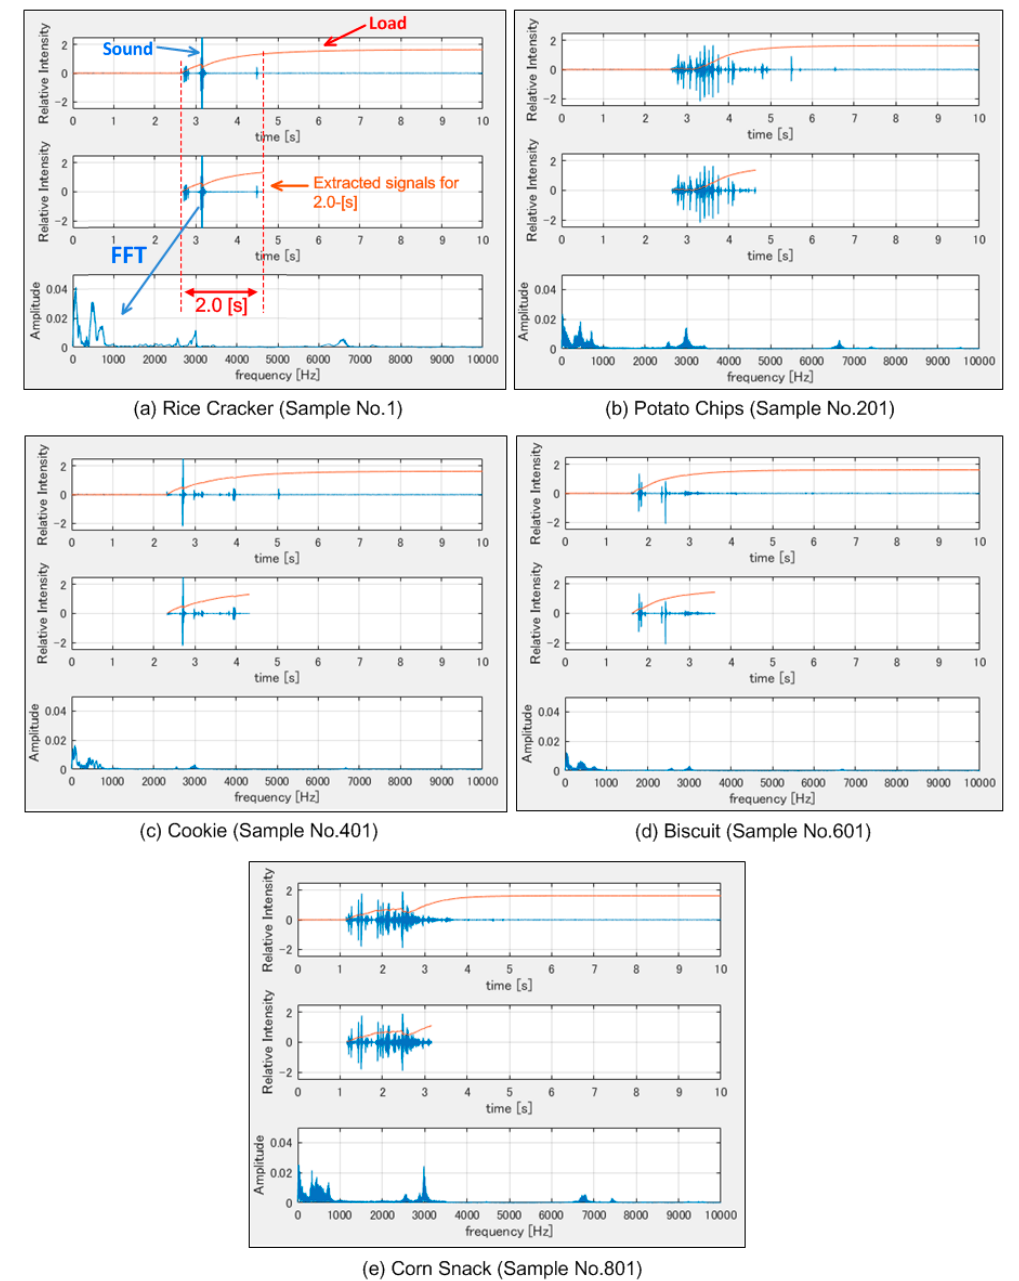
prior to evaluation and; ( b ) potato chips being crushed.